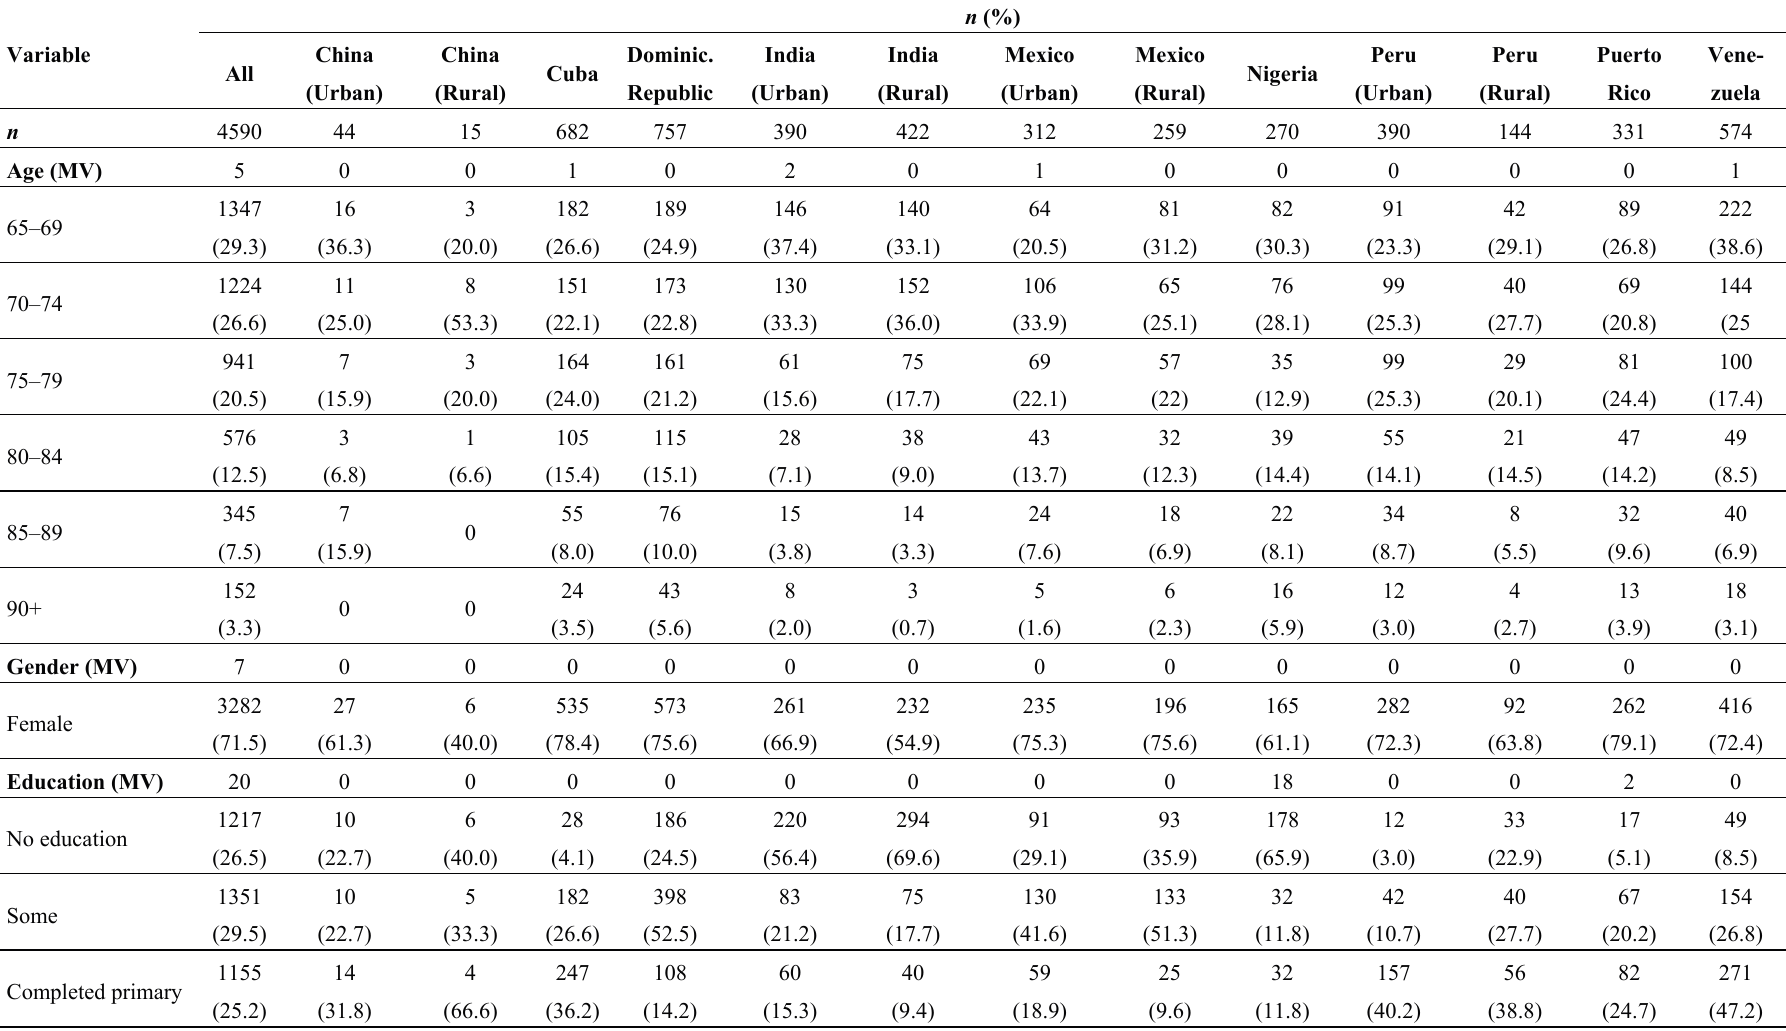
Table 1. Sociodemographic and clinical characteristics of